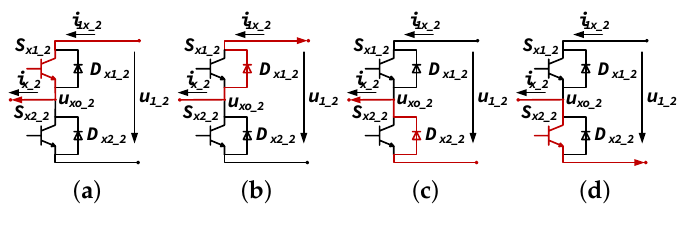
Figure 3. Current paths in a single two-level arm.